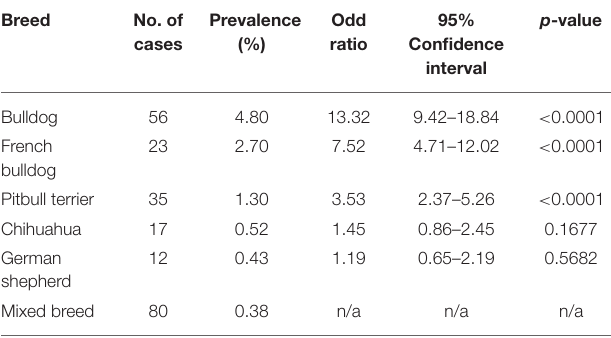
TABLE 3 | Odds ratio by breed with ≥ 10 cases for pulmonic stenosis (PS).